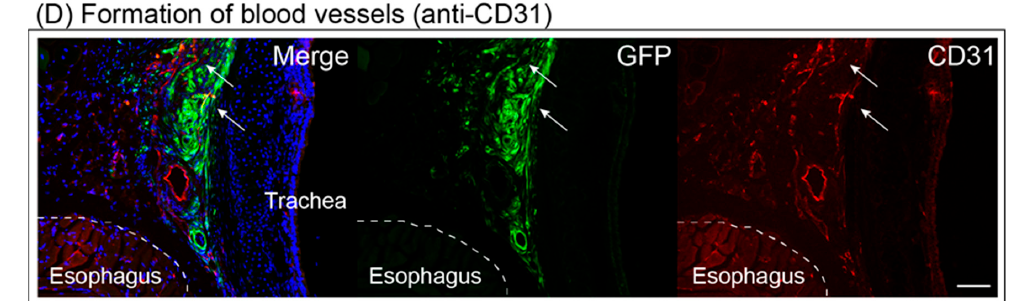
Figure 5. Differentiation of engrafted GFP + cells after eight weeks of transplantation. ( A ) Differentiation into Schwann cells. Anti-p75 + (Schwann cell marker, red)/GFP + cells were observed close to the esophagus and trachea, which is the situation of the RLN. ( B ) Formation of perineurium/endoneurium in the RLN situation. Anti-GLUT-1 + (marker for the perineurium/endoneurium, red)/GFP + cells also located in the RLN situation forming lots of typical large and small circle-like shapes. ( C ) Typical formation of skeletal muscle cells (anti-skeletal actin + fibers, arrowheads) in the tracheal muscle. ( D ) Formation of blood vessels confirming anti-CD31 in the area of the RLN. Some of these were double positive for CD31 and GFP, showing endothelial cell differentiation. Blue staining in all panels is nuclear staining of DAPI. Bars = 100 μ m.